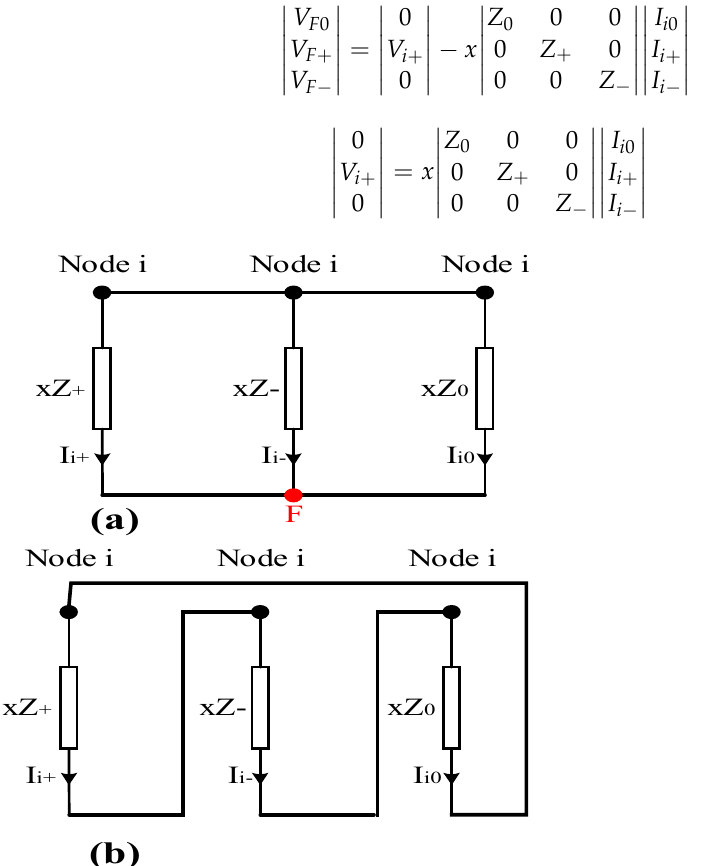
Figure 13. Equivalent circuit of symmetric components for a fault ( a ) One open conductor, ( b ) Two open conductors.